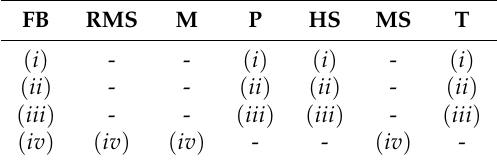
Table 5. FRIs combination to obtain Multiple Correspondence Analysis (MCA) results.